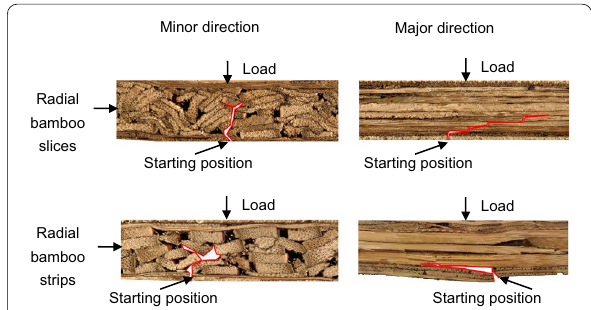
Fig. 8 Observed failure types in the specimens at the major and minor strength directions during bending